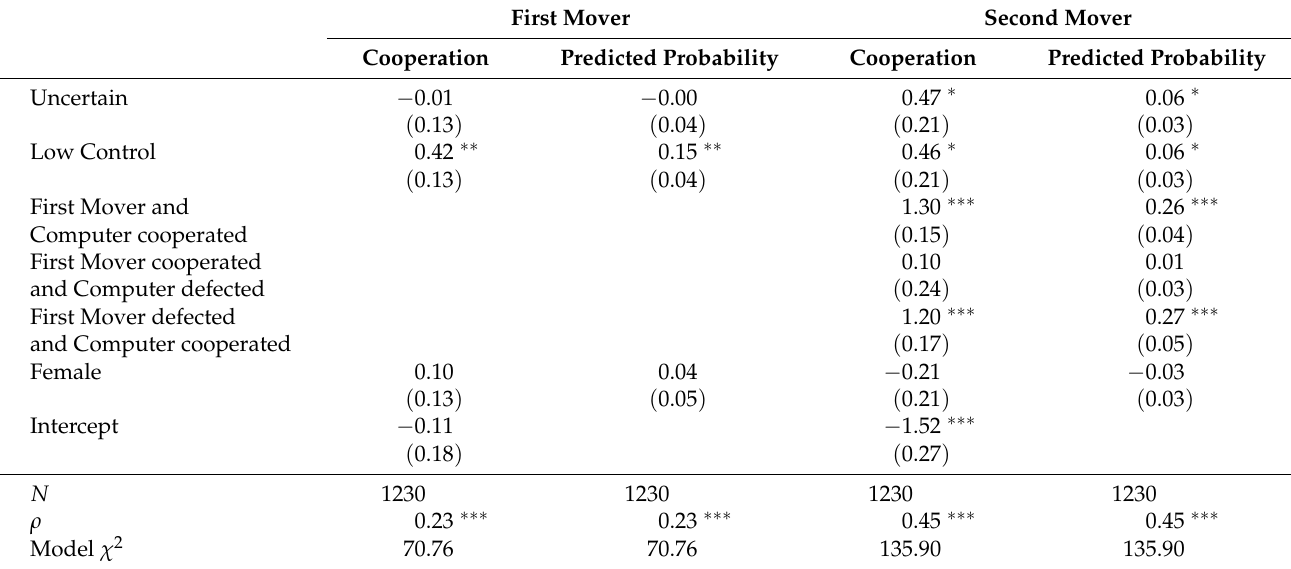
Figure 3. Average Second Mover Cooperation by Treatment (First 10 Rounds). Table 2. First Mover and Second Mover Cooperation (First 10